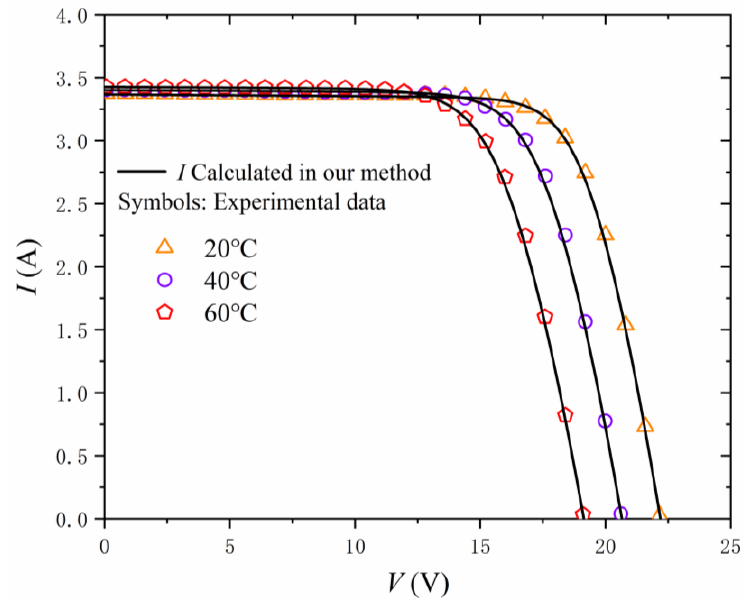
Figure 9. Absolute errors of I-V characteristics between symbols and lines in Figure 7. Table 5. Parameter estimation values for I- and P-V characteristics in Figures 7 and 8.